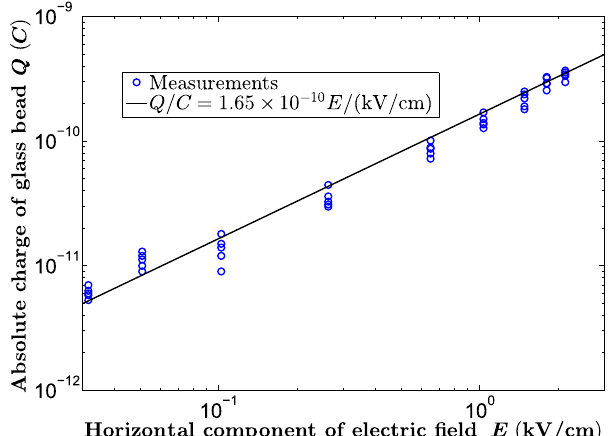
FIG. 4. Experiments within silicone oil: Two contacting glass beads ( r ¼ 1 mm) placed on fibers hanging down a bar. Mea- surements of the absolute value of the charge of the glass beads as a function of the electric field component in the direction normal to the contact plane after removal of one of the